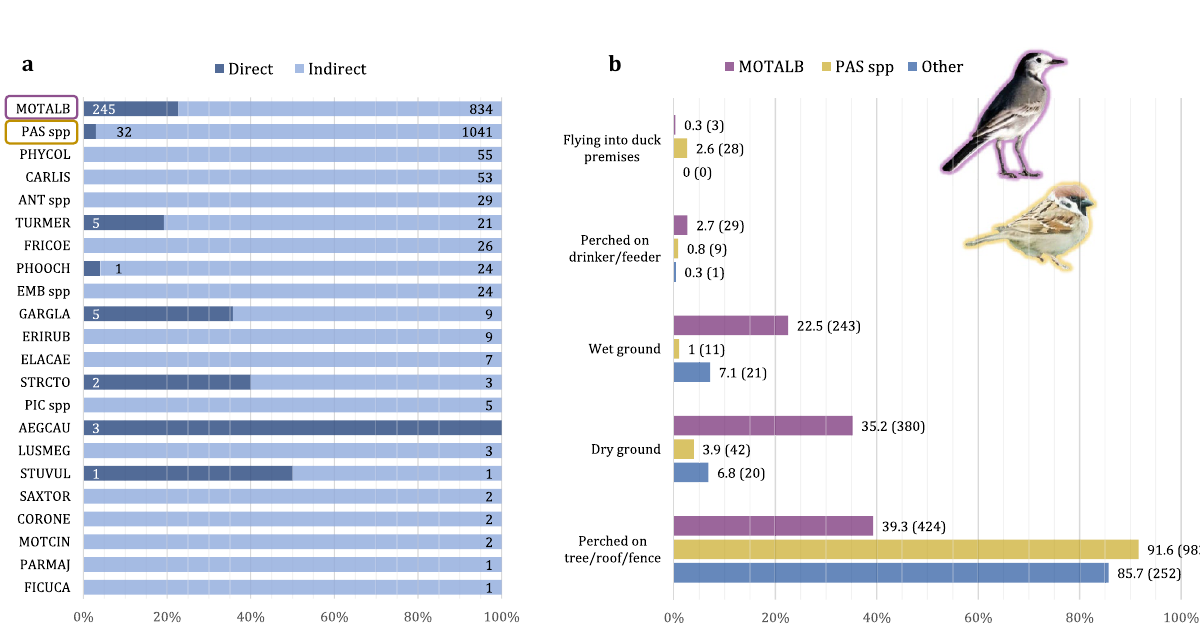
Figure 3. Distribution of cumulative numbers of individuals by species or species group involved in different types of interactions with domestic ducks over 953 observations of 2,446 cumulative individuals in total. ( a ) Distribution by proximity with ducks, considering a direct interaction as a distance to ducks closer than one meter (indirect otherwise). ( b ) Distribution by type of behaviour in the two most abundant species groups compared to all others. Species names are coded as follows: AEGCAU: Aegithalos caudatus ; ANT spp: Anthus spp .; CARLIS: Carduelis carduelis ; CORONE: Corvus corone ; ELACAE: Elanus caeruleus ; EMB spp: Emberiza spp .; ERIRUB: Erithacus rubecula ; FICUCA: Ficedula hypoleuca ; FRICOE: Fringilla coelebs ; GARGLA: Garrulus glandarius ; LUSMEG: Luscinia megarhynchos ; MOTALB: Motacilla alba ; MOTCIN: Motacilla cinerea ; PARMAJ: Parus major ; PAS spp.: Passer domesticus & P. montanus ; PHOOCH: Phoenicurus ochruros ; PHYCOL: Phylloscopus collybita ; PIC spp.: Picidae ; SAXTOR: Saxicola rubicola ; STRCTO: Streptopelia decaocto ; STUVUL: Sturnus vulgaris ; TURMER: Turdus merula